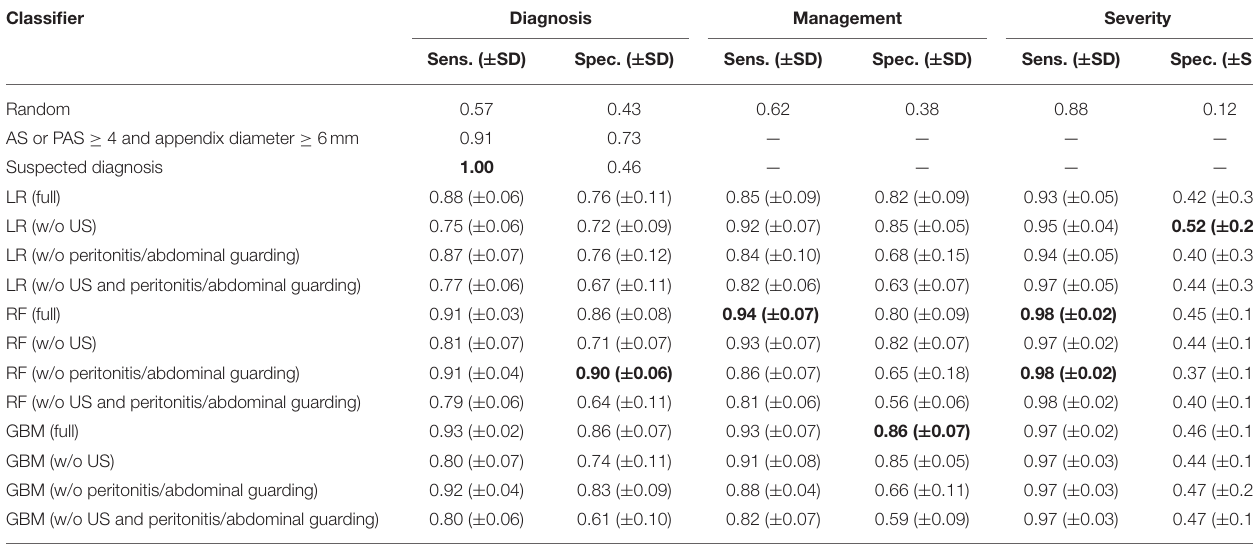
TABLE 4 | Ten-fold cross-validation results for logistic regression (LR), random forest (RF), and generalized boosted regression (GBM) models for predicting diagnosis, management, and